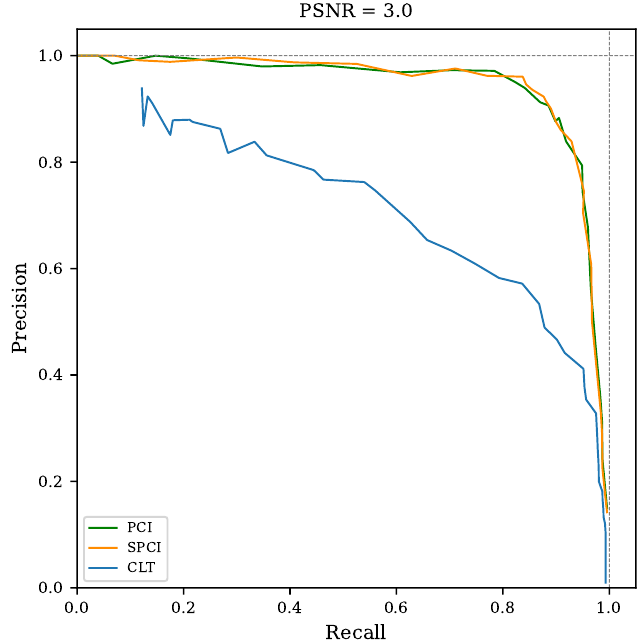
Figure 13. PR curves of both correlation indices (PCI and SPCI) and simple cross-level trigger (CLT). The plot axes were set using the threshold ranges specified in Section 5.